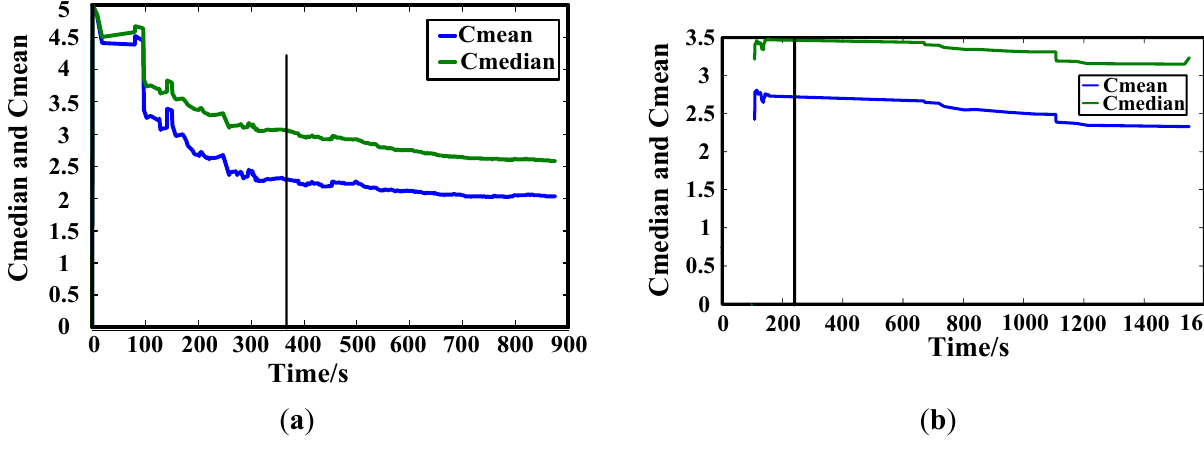
Figure 6. C mean and C median curve for AE signal of the tensile samples. ( a ) Sample a; ( b ) Sample